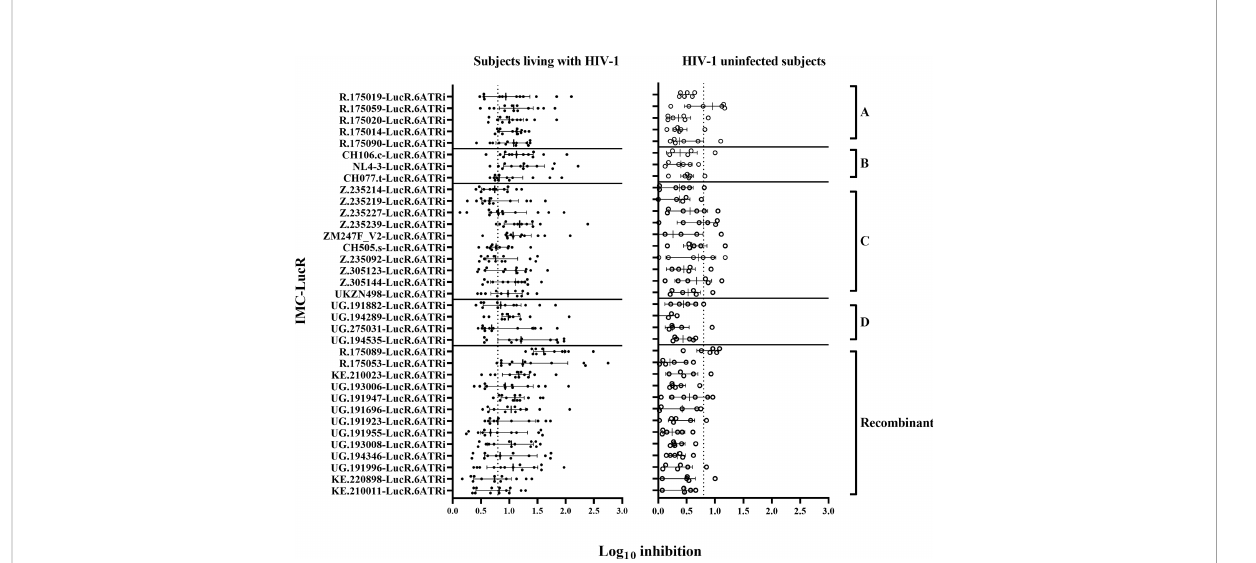
FIGURE 3 CD8 T-cell-mediated inhibition of HIV-1 replication in autologous CD4 T-cells. Inhibition in T-cell cultures from ART naive subjects living with HIV-1 (on the left panel), and HIV-1 uninfected subjects (on the right panel) arranged by IMC HIV-1 clade (A-D) , and Recombinant). Inhibition is measured as log 10 reduction RLU of CD4 and CD8 T-cell co-cultures compared with infected CD4 T-cells alone. Each data point represents the mean RLU of duplicated values for each CD4 T-cell infected with a speci fi c HIV-1 IMC-LucR. Bars represent RLU median with interquartile range. The dotted line represents the assay positivity value (>0.8 log 10